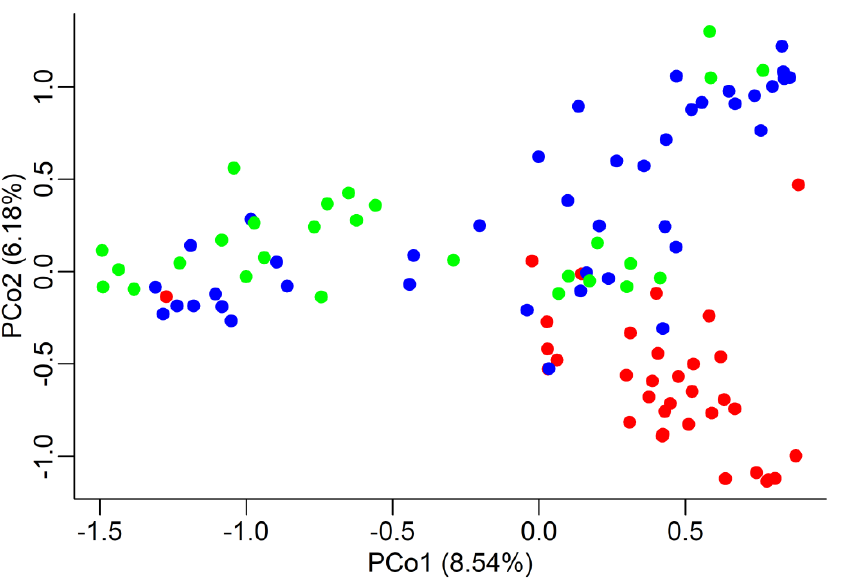
Figure 2. Principal Coordinate Analysis (PCoA). Each chestnut tree is represented by a dot in a two- dimensional space represented by the two first Principal Coordinates, which explain, respectively, 8.54% and 6.18% of the total variation. The Euclidean distance between trees is based on their genotypic differences. Different regions are represented by different colours: red = Garfagnana (G), blue = Colline Metallifere (CM), green = Monte Amiata (MA). The red dot on the extreme left is tree G17 (see text for details).